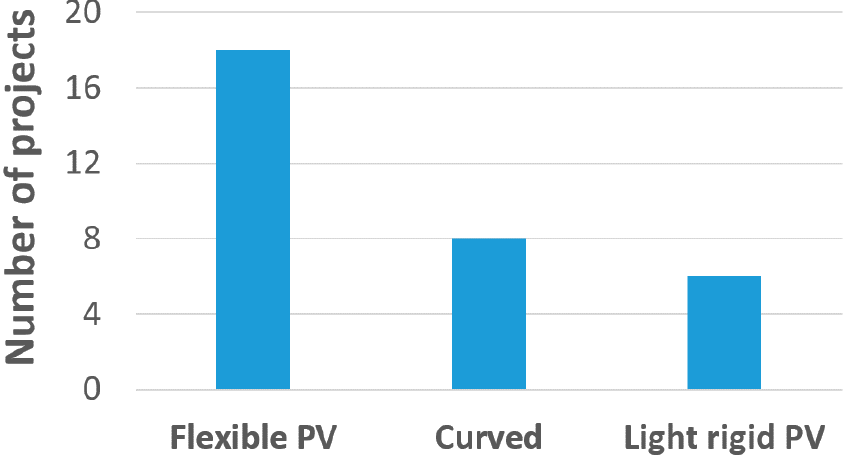
Figure 6. Number of projects for each type module technology.